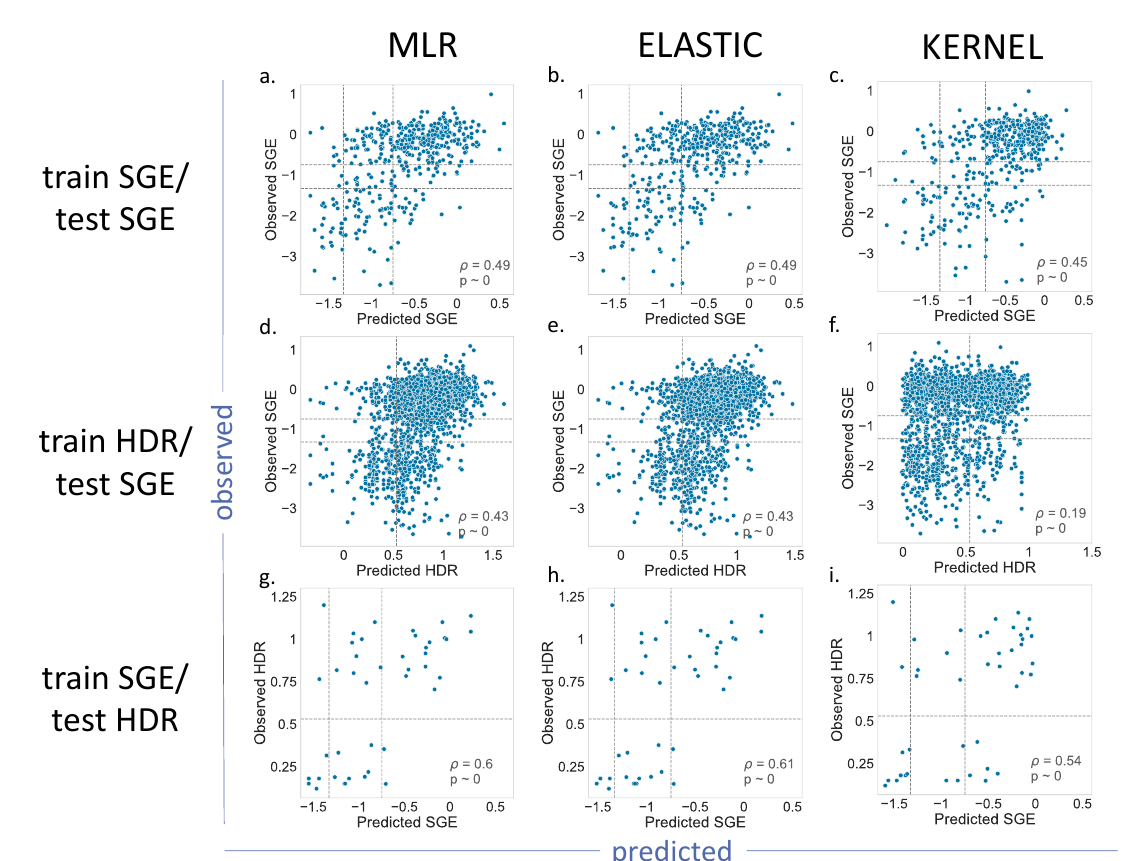
Figure 4. Observed vs. Predicted endophenotypes for the ( a , d , g ) MLR, ( b , e , h ) Elastic and ( c , f , i ) Kernel regressions. BRCA1 case. Each row corresponds to the results obtained with a specific combination of training/test datasets. For example, for the train SGE/test SGE, the dataset was split into a training and a test dataset containing 75% and 25% of the variants, respectively. The different training/test combinations used are described in Table 1. Note that, for the combinations of train HDR/test SGE and train SGE/test HDR, the endophenotypes used for training and those providing the testing sets, i.e., the observations, corresponded to different assays. The dashed lines indicate the functionality thresholds defined in the literature for these assays and used in this work to binarize the prediction output into benign/pathogenic classes.